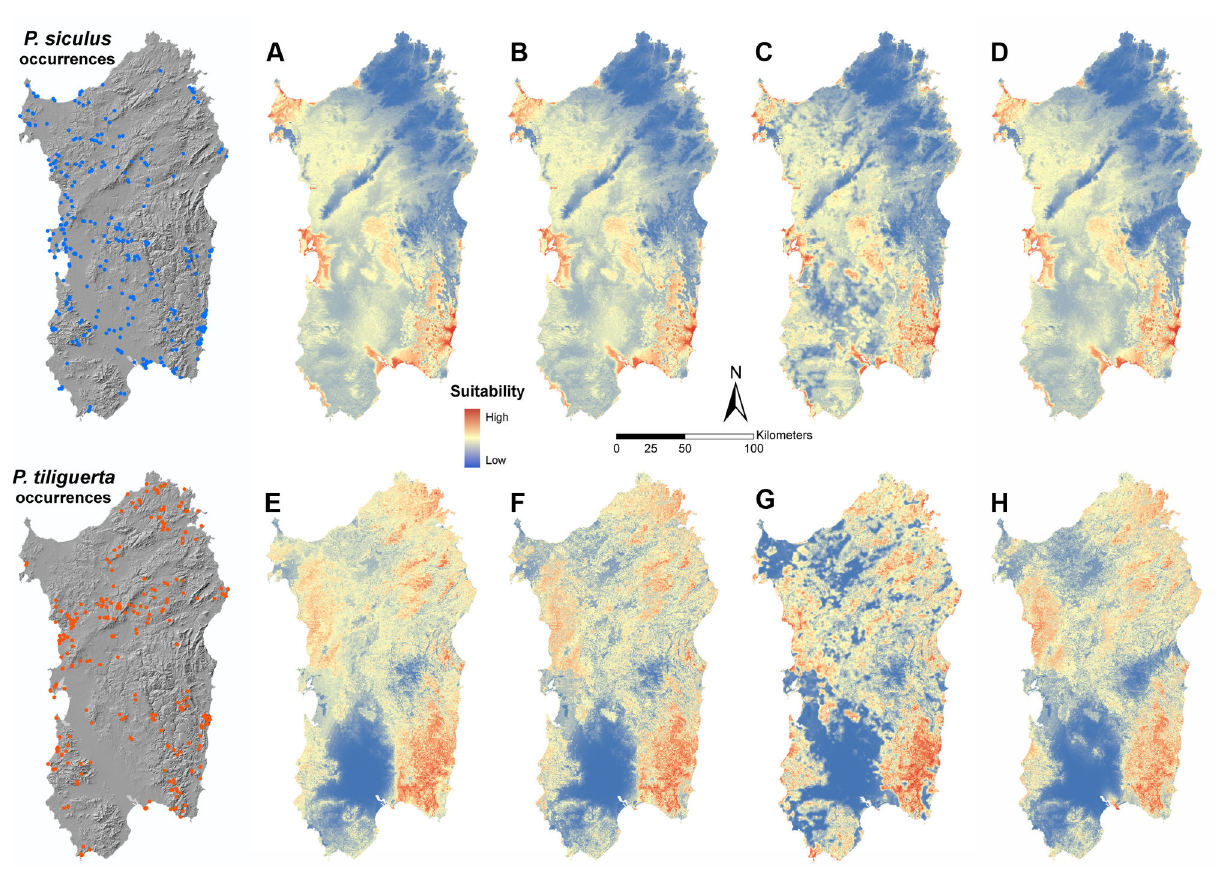
Figure 2. Maps of the competing SDM. A, B, C, D represent the models under hypotheses respectively H siculus . E, F, G, H represent the same hypotheses for P. tiliguerta . Occurrences are also shown in separate maps. doi: